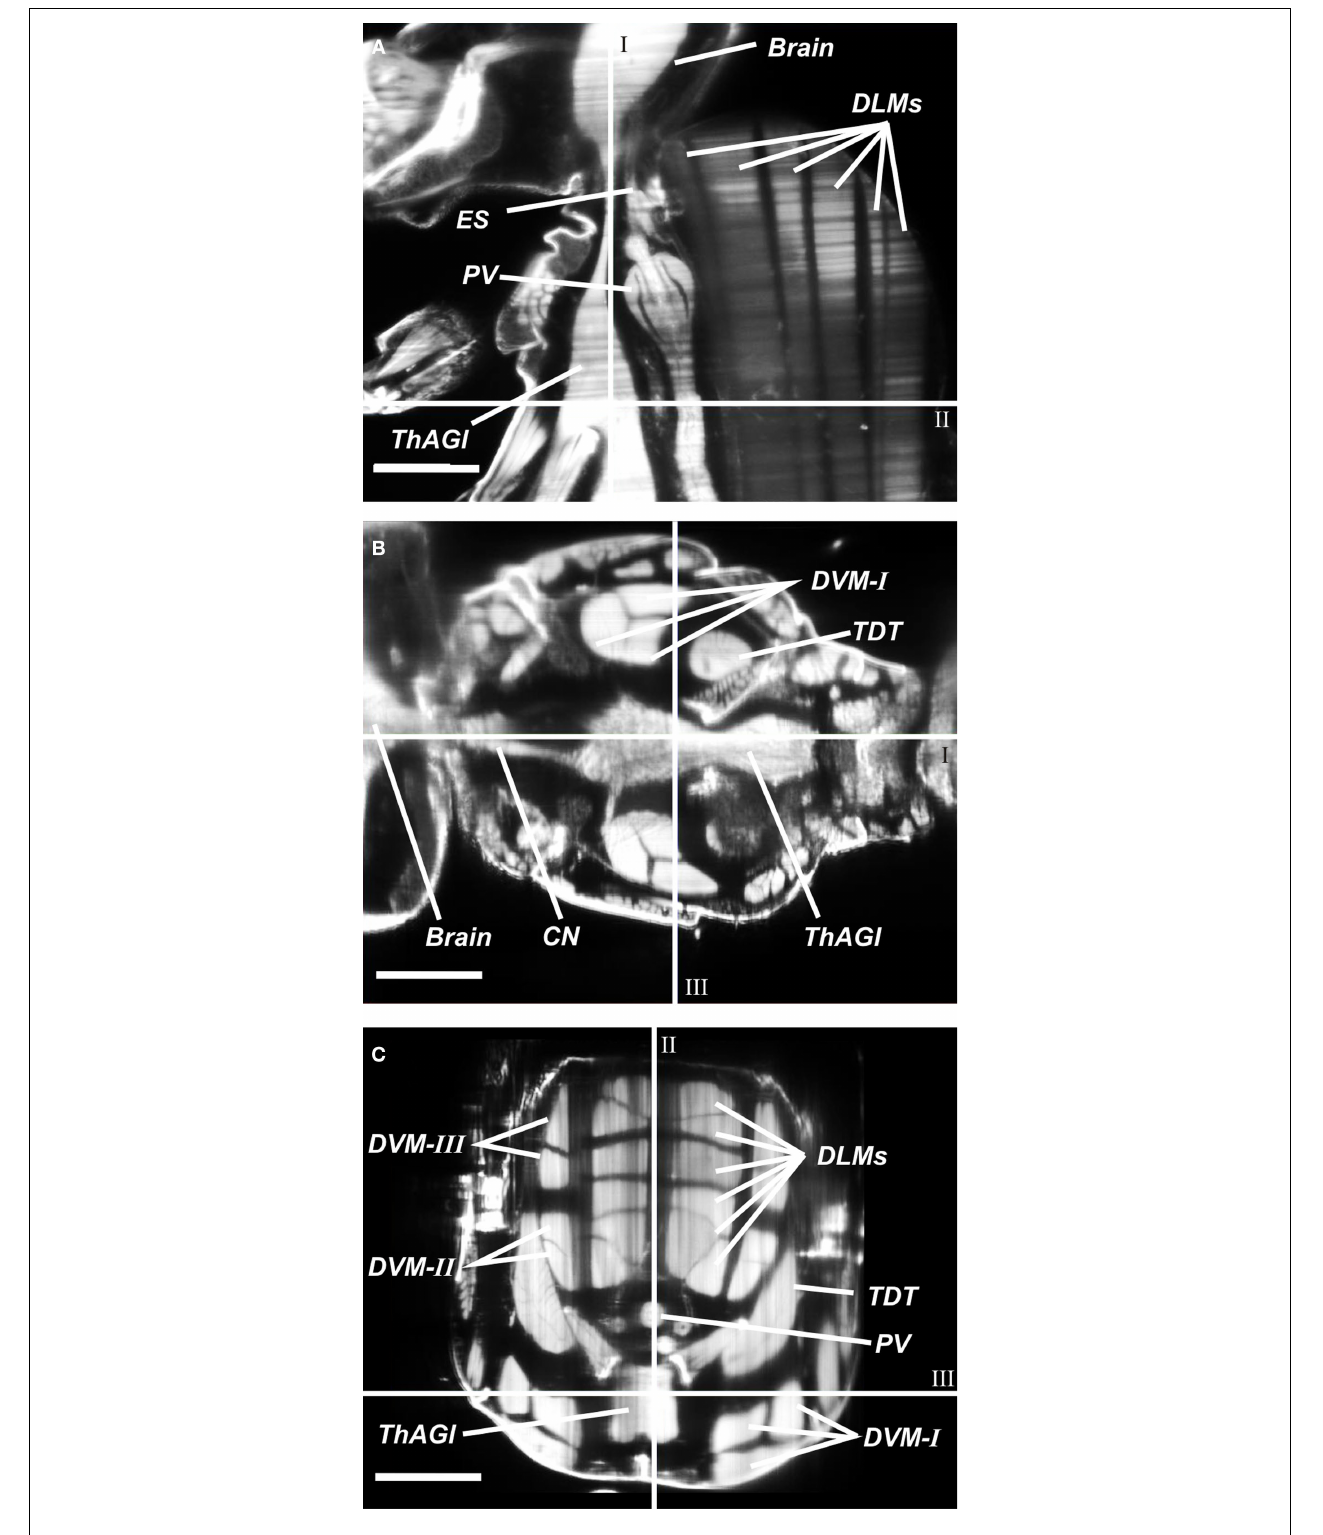
FIGURE 4 | Cross sections in three orthogonal directions (A–C) were used to segment anatomical structures in three different orientations. ES, oesophagus; CN, cervical connective; DLMs, dorsal longitudinal muscles; DVM-I/-II/-III, dorsal–ventral muscles; PV, proventriculus; TDT, tergal depressor